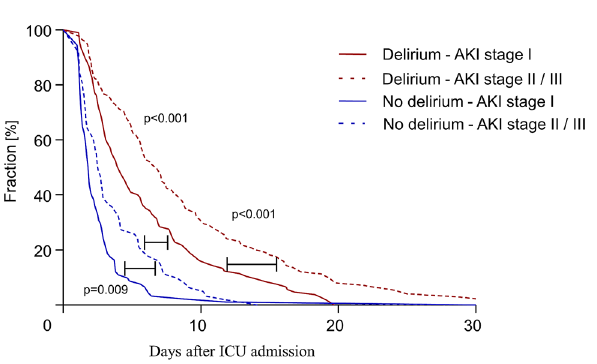
Figure 4. Duration of stay on the ICU. Graph showing ICU stay of all patients with acute kidney injury (AKI) staying for more than 24 h on the ICU separated by stage of AKI and incidence of